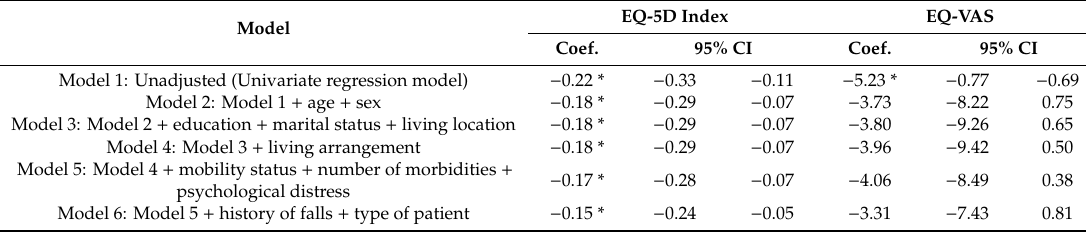
Table 5. Tobit regression models to identify the association between FOF status and EQ-5D index and EQ-VAS. EQ-5D Index EQ-VAS Model Coef. 95% CI Coef. 95% CI Model 1: Unadjusted (Univariate regression model) − 0.22 * − 0.33 − 0.11 − 5.23 * − 0.77 − 0.18 * − 0.29 − 0.07 − 0.18 * − 0.29 − 0.17 * − 0.28 0.38 Model 6: Model 5 + history of falls + type of patient − 0.15 * − 0.24 − 0.05 − 3.31 − 7.43 0.81 * p <